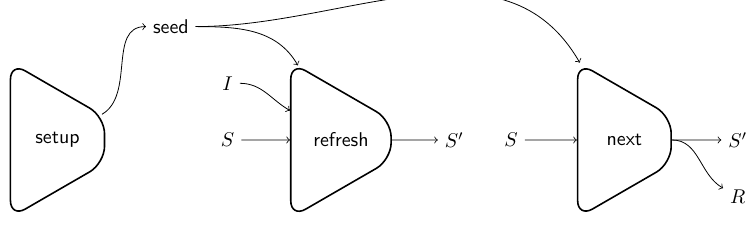
Figure 17: PRNG with Input [DPR +